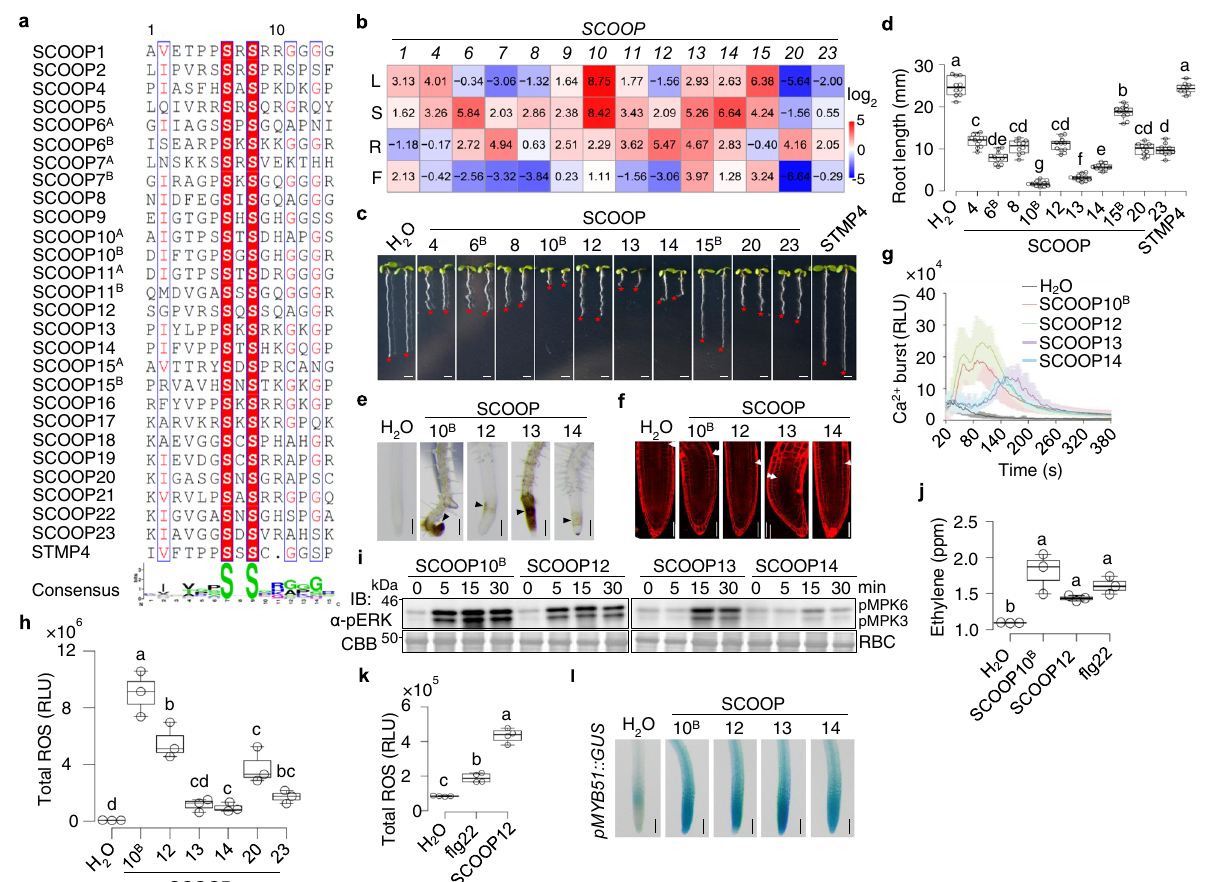
Fig. 2 SCOOP peptides activate plant immune responses. a Alignment of SCOOP SxS motifs. Two SxS motifs in SCOOP6, 10, and 11 are respectively indicated with A and B. The conserved and similar residues are in red and yellow, respectively. b Expression of SCOOPs in different tissues. Heatmap represents adjusted log 2 transformed transcript levels in 4-week-old leaves (L), 7-week-old fl owers (F), and 10-day-old shoots (S) and roots (R). Data represent averages of relative expression levels of SCOOPs normalized to UBQ10 from three independent repeats. c , d SCOOPs inhibit root growth. Images of 10-day-old seedlings with 1 µ M peptides: Red stars indicate the root tips, scale bar, 4 mm ( c ); quanti fi cation of root length ( d ). e SCOOPs cause root browning. Microscopic images of root tips with arrowheads indicating browning. Scale bar, 500 µ m. f SCOOPs distort root meristems. Confocal images of root tips of 5-day-old seedlings with 1 µ M peptides for 48 h and propidium iodide (PI) staining. Arrowheads indicate boundaries of root meristems and elongation zones. Scale bar, 100 µ m. g SCOOPs trigger cytosolic Ca 2 + increases. p35S::Aequorin seedlings were treated with 100 nM SCOOPs. Cytosolic Ca 2 + concentration is indicated as means ± SE of RLU ( n = 4, SCOOP10 B and SCOOP12; n = 3, H 2 O, SCOOP13, and SCOOP14). h SCOOPs induce ROS production. One-week-old seedlings were treated with 100 nM peptides, and ROS production was calculated as total RLU. i SCOOPs induce MAPK activation. Ten-day-old seedlings were treated with 1 µ M peptides, and MAPK activation was analyzed by α -pERK1/2 immunoblotting (IB). Coomassie brilliant blue (CBB) staining of Rubisco (RBC) for protein loading. Molecular weight (kDa) was labeled on the left of all immunoblots. j SCOOPs induce ethylene production. Ethylene concentration in leaf disks was indicated as parts per million (ppm). k SCOOP12 induces a robust ROS production in roots. Detached roots from 1-week-old seedlings were treated with 100 nM peptides. l SCOOPs induce expression of pMYB51::GUS in roots. Microscopic images of root tips of 1-week-old pMYB51::GUS seedlings treated with 1 µ M SCOOPs for 3 h and subjected to GUS staining. Scale bar, 1 mm. Box plots in ( d ), ( h ), ( j ), and ( k ) show the fi rst and third quartiles as bounds of box, split by the medians (lines), with whiskers extending 1.5-fold interquartile range beyond the box, and minima and maxima as error bar. Different letters indicate a signi fi cant difference with others ( P < 0.05, one-way ANOVA followed by Tukey ’ s test, n = 10, 11, 11, 10, 11, 11, 11,10, 11, 10, 10, 9 for plots from left to right in ( d ); n = 3 for plots in ( h ) and ( j ); n = 4 for plots in ( k ). Experiments in ( b – e ), and ( g – l ) were repeated three times, and ( f ) twice with similar